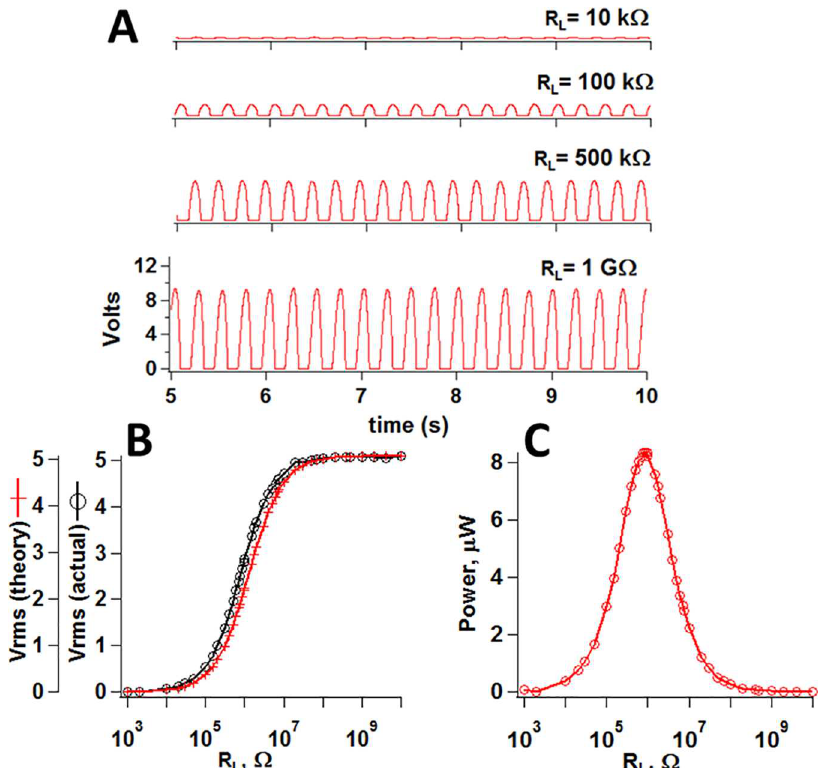
Fig 3. Effect of load resistanceon energyconversionby a triplex stack of PVDF elementsexcited by repetitive pulses of N 2 gas at 4 Hz: (A) Primary data show progressive drop in voltagewith R L . (B) Measured (circles) and theoretical(crosses) RMS voltagedrops across load resistance; (C) Effect of R L on power (V 2 / R L ), with optimal harvestingnear 1 M Ω